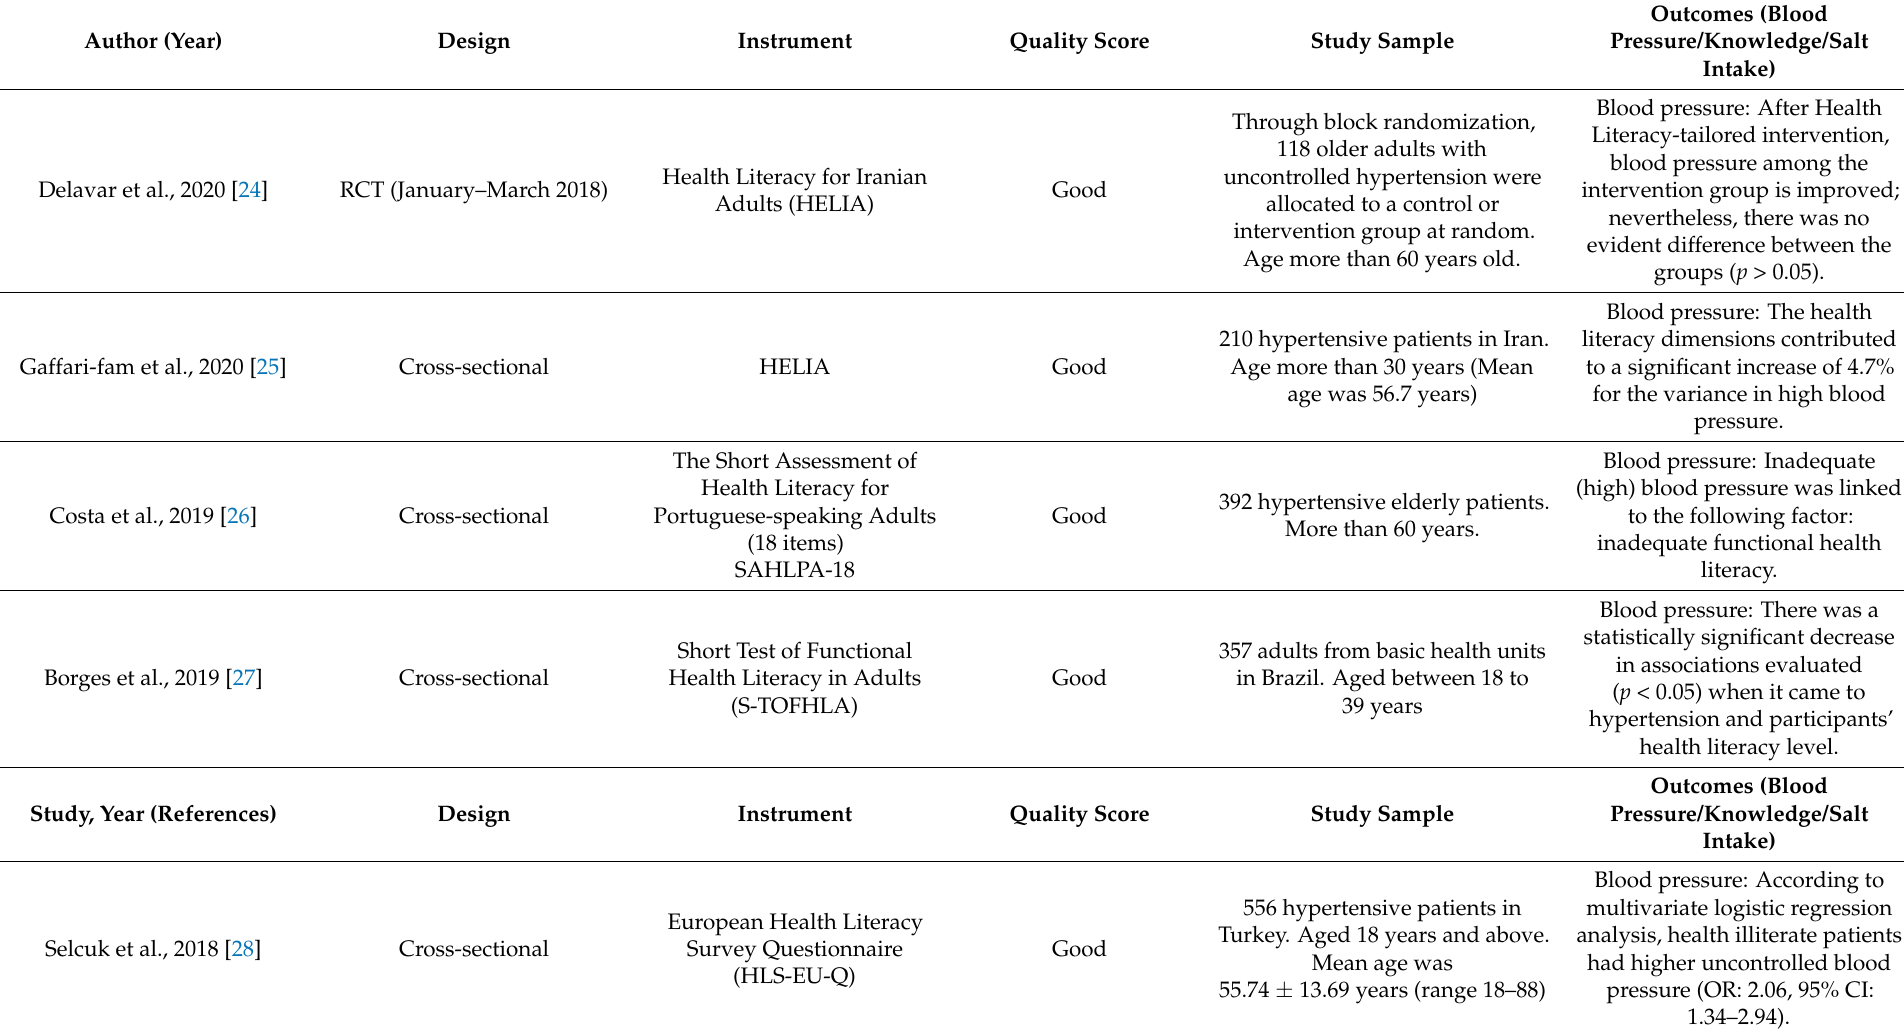
Table 3. General characteristics of studies included in the final